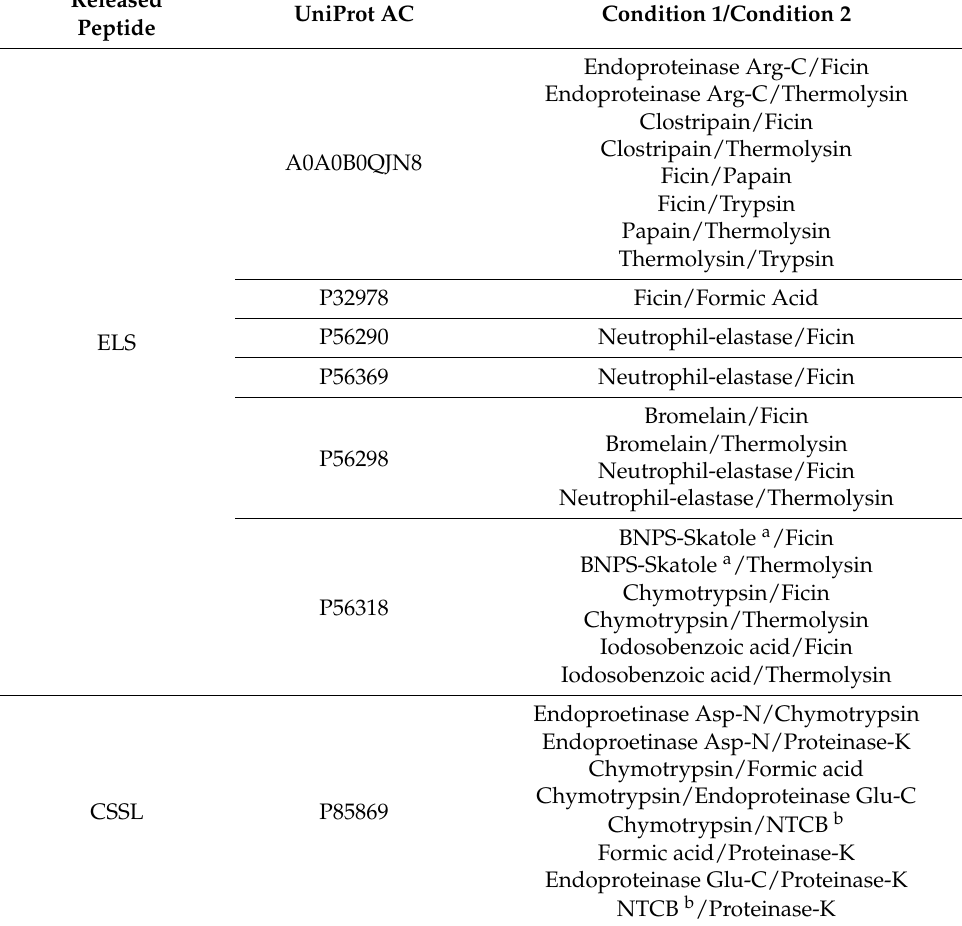
Table 4. Released peptides after the in silico digestion procedure using RPG